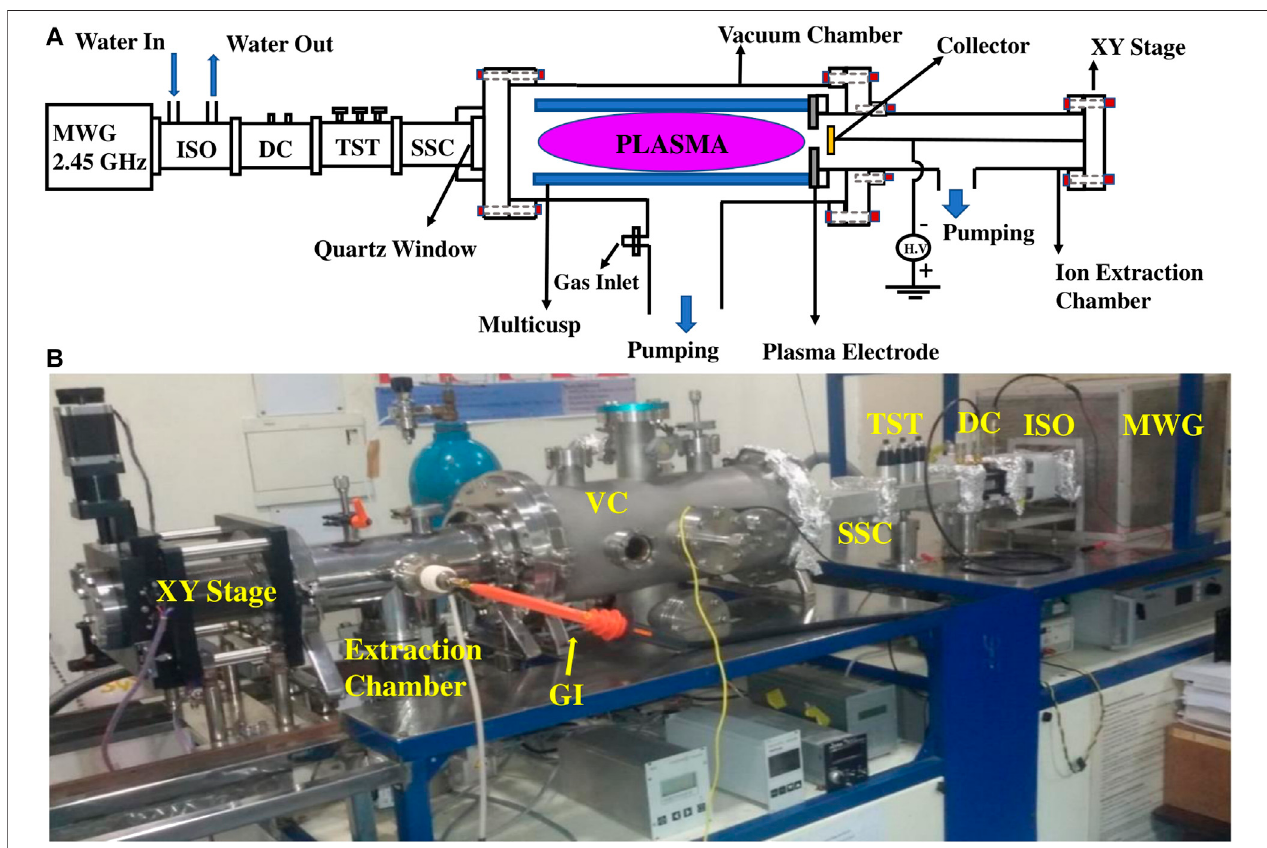
FIGURE1|(A) Schematicdiagramand (B) digitalpictureofexperimentalsetup.MWG,microwavegenerator;ISO,isolator;DC,directionalcoupler;TST,triplestub tuner; SSC, straight section; GI, gas inlet; and VC, vacuum chamber.